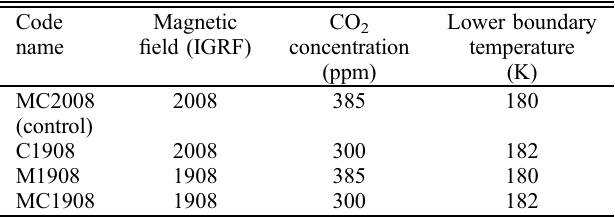
Table 1. Overview of the simulation settings